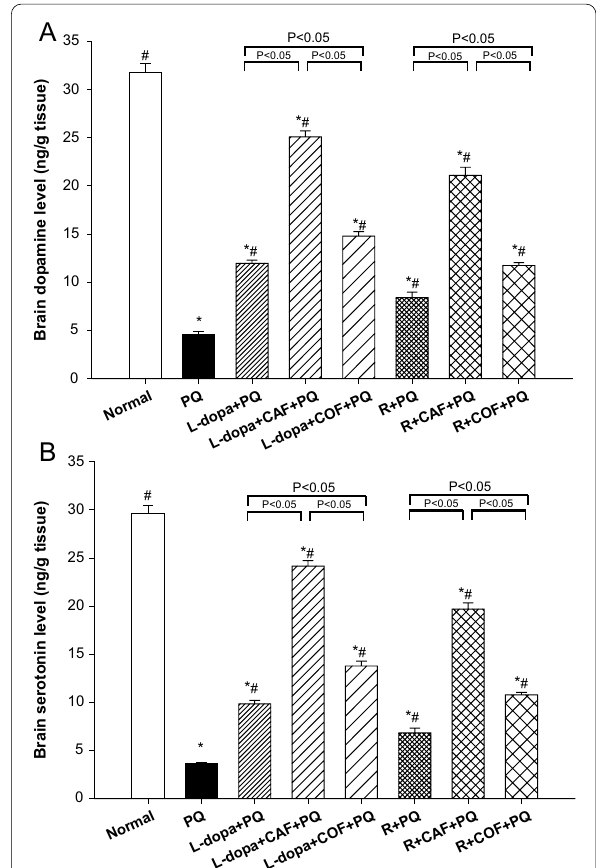
Fig. 2 Effect of each l -dopa and rasagiline (R) alone or in combination with caffeine (CAF) or coffee (COF) on brain neurotransmitters in paraquat (PQ)-treated mice. A Brain dopamine level, B Brain serotonin level. Data are presented as mean Differences between groups were statistically analyzed using a one-way analysis of variance followed by a Student–Newman–Keuls post hoc comparison. *Significant from normal group P < 0.05. # Significant from PQ group P < 0.05. Lines represent significance P